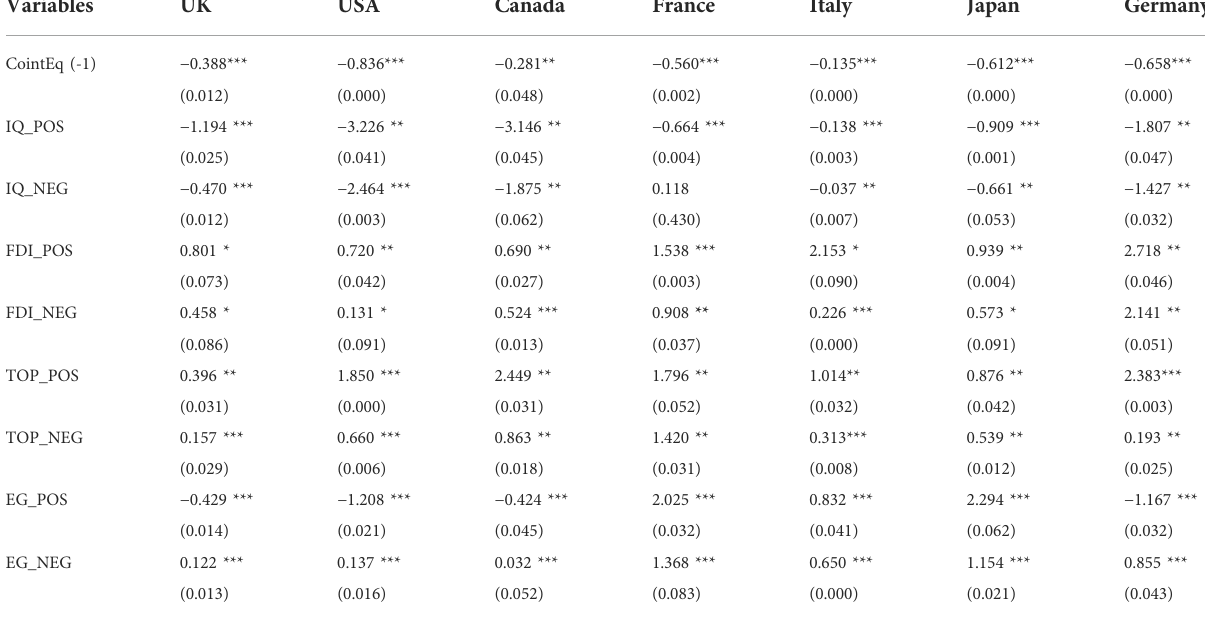
TABLE 6 Long-run asymmetric relationship.